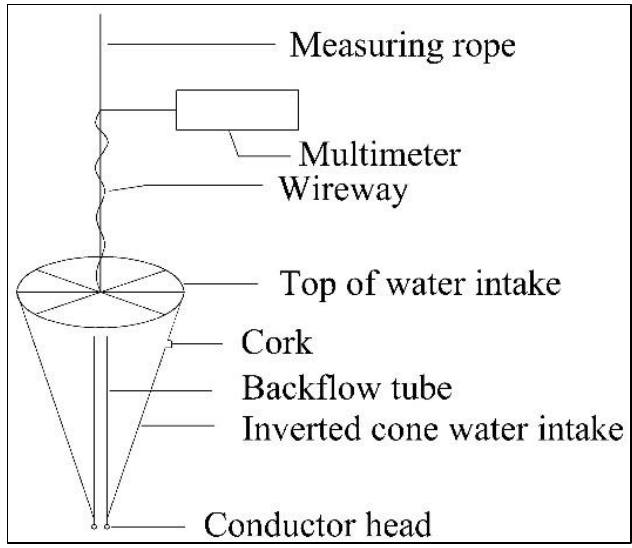
Figure 3. Sampling Points.